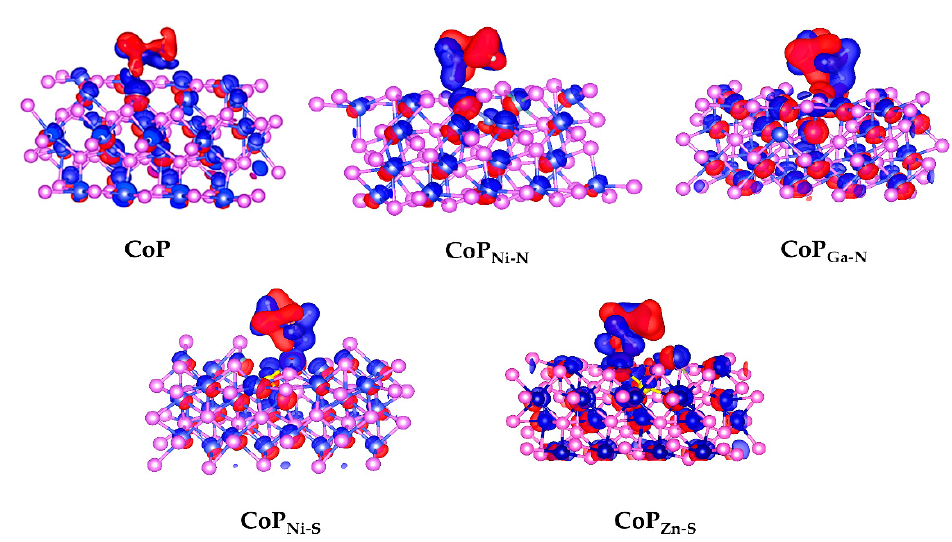
Figure 5. CDDs maps of CoP, CoP Ni-N , CoP Ga-N , CoP Ni-S, and CoP Zn-S catalyzed NH 3 BH 3 .